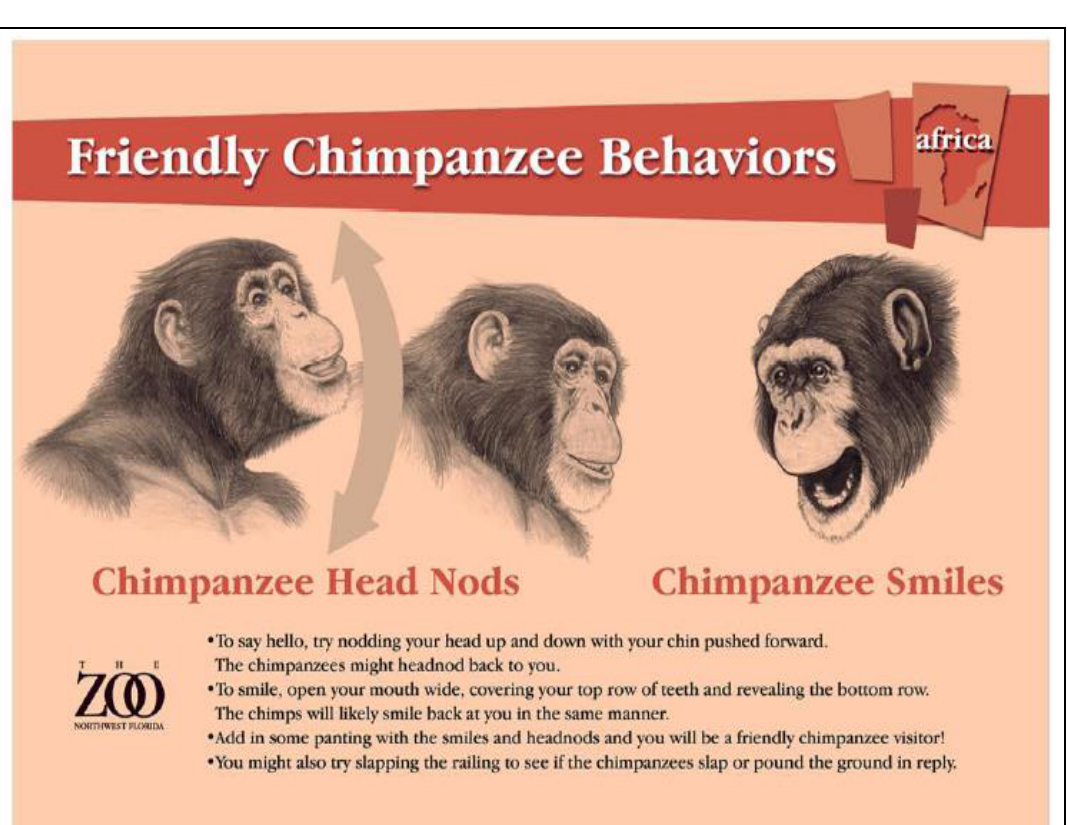
Design of the Graphic Sign Posted on the Railing of the Visitor Platform During the Sign